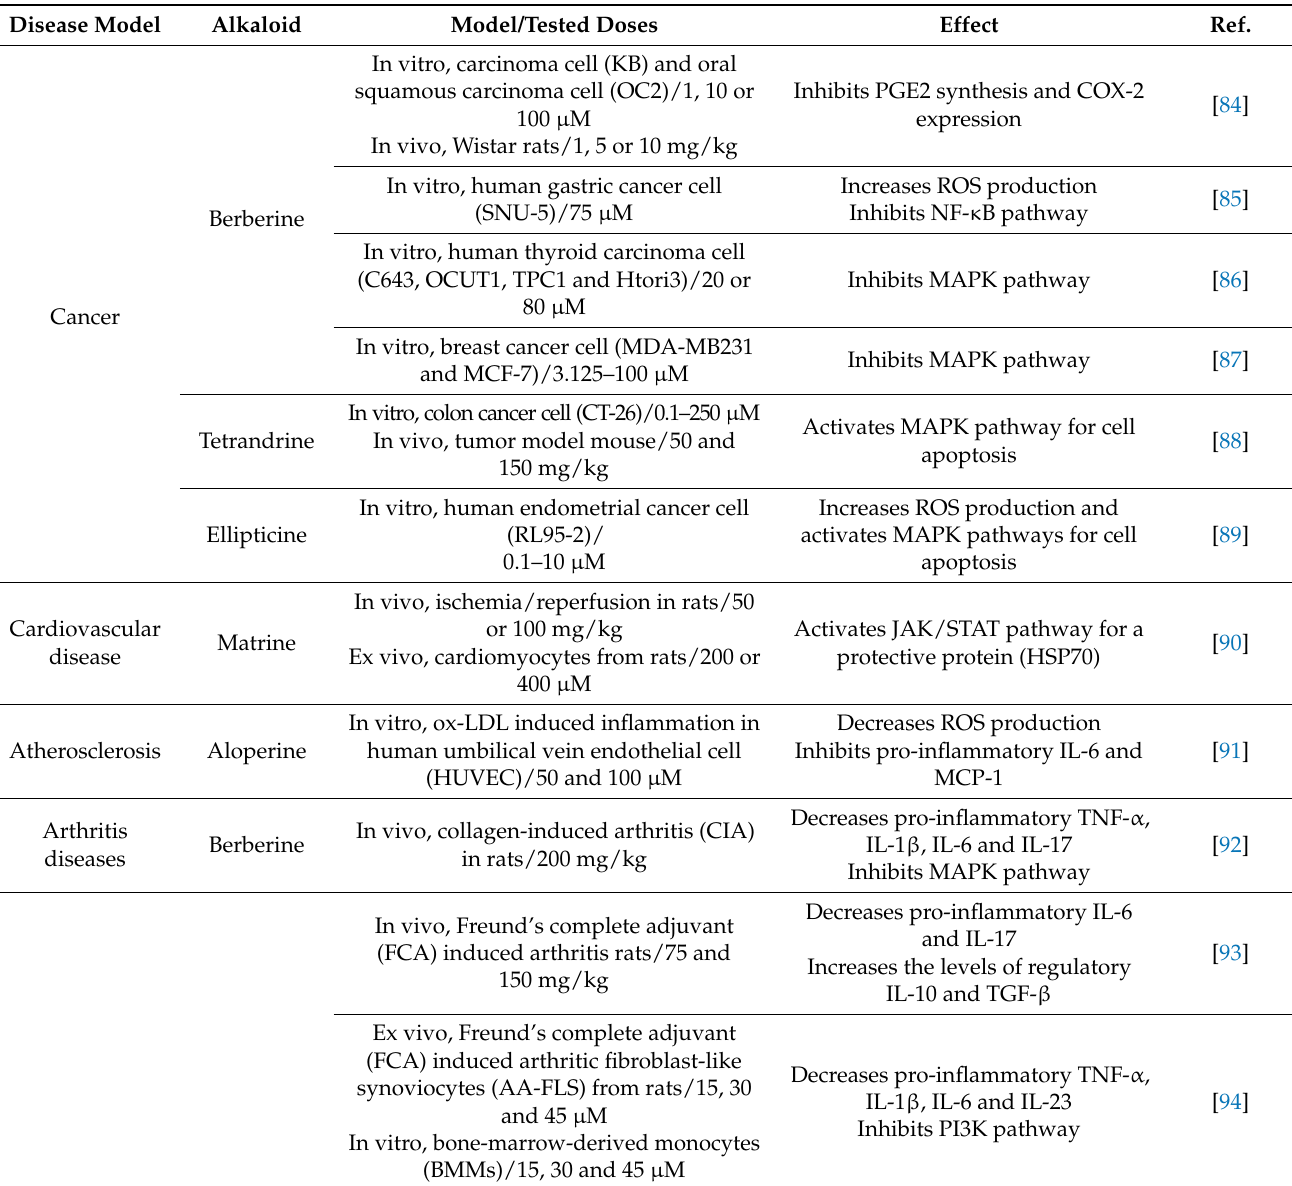
Table 2. Immunomodulatory effects of alkaloids in non-viral related